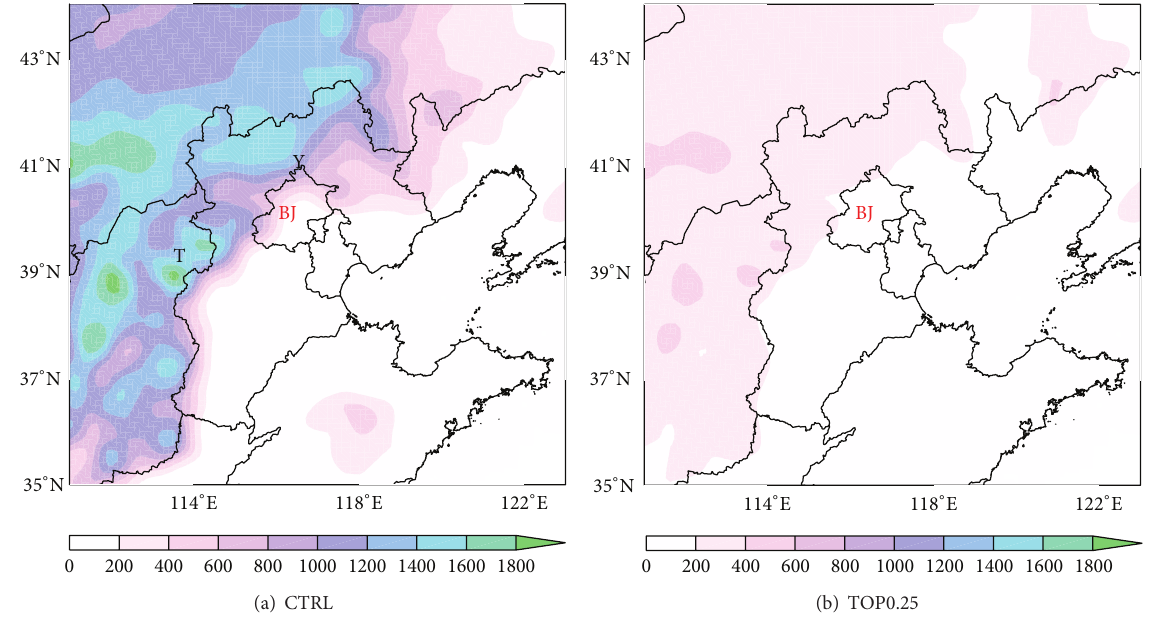
Figure 4: Elevation (shaded, unit: m) from (a) the actual and (b) %25 mountain topographic grids; “T” and “Y” indicate Taihang Mountain and Yanshan